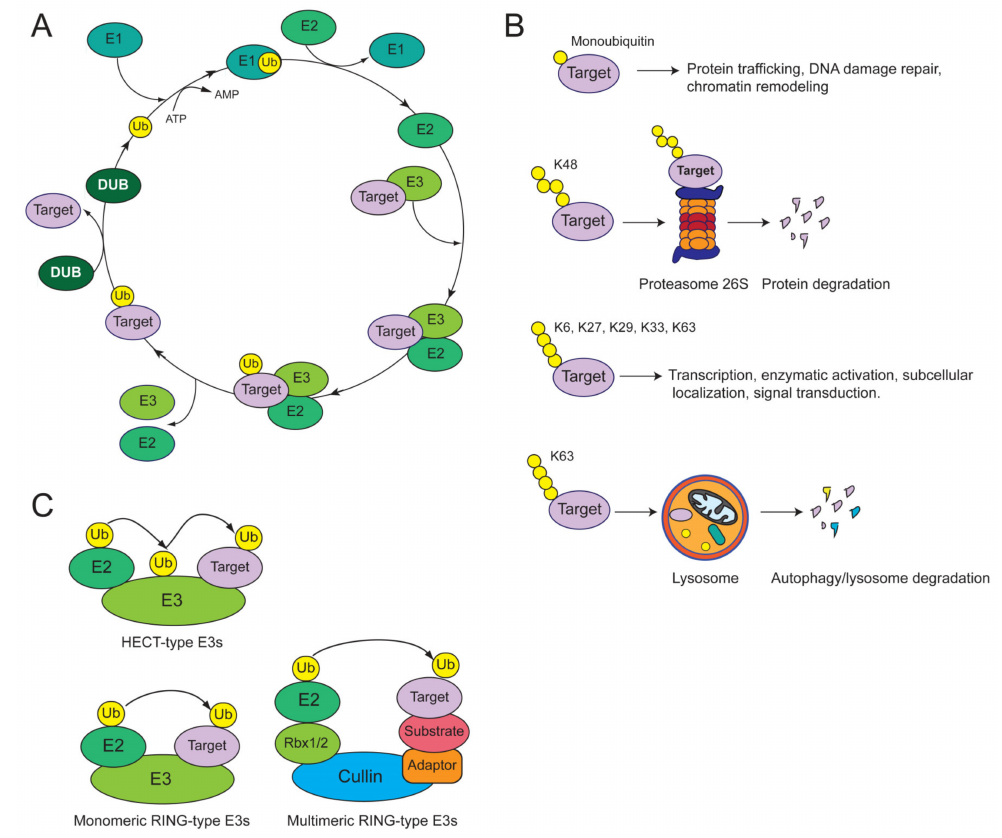
Figure 1. ( A ) The addition of ubiquitin to a target protein is a multistep, ATP-dependent process performed in three sequential enzymatic steps: activation of ubiquitin by an E1 ubiquitin activating enzyme, transfer of ubiquitin to one E2 ubiquitin conjugating enzyme and, lastly, the E3 ligase-mediated transfer of ubiquitin from E2 to the substrate protein. Ubiquitination can be reversed by deubiquitinating enzymes (DUBs), a family of isopeptidases that catalyze the removal of ubiquitin from target proteins. ( B ) Fate of ubiquitin-modified proteins. ( C ) Structural architecture and catalytic properties of HECT- and the RING finger-type E3s. HECT-type E3s form a thioester-linked intermediate with ubiquitin before catalyzing its transfer to the substrate. The RING-type E3s act as platforms for recruiting the E2 thioester-linked to ubiquitin and for juxtaposing the E2 and the substrate for the ubiquitin transfer. This family comprises of both monomeric and the multi-subunit